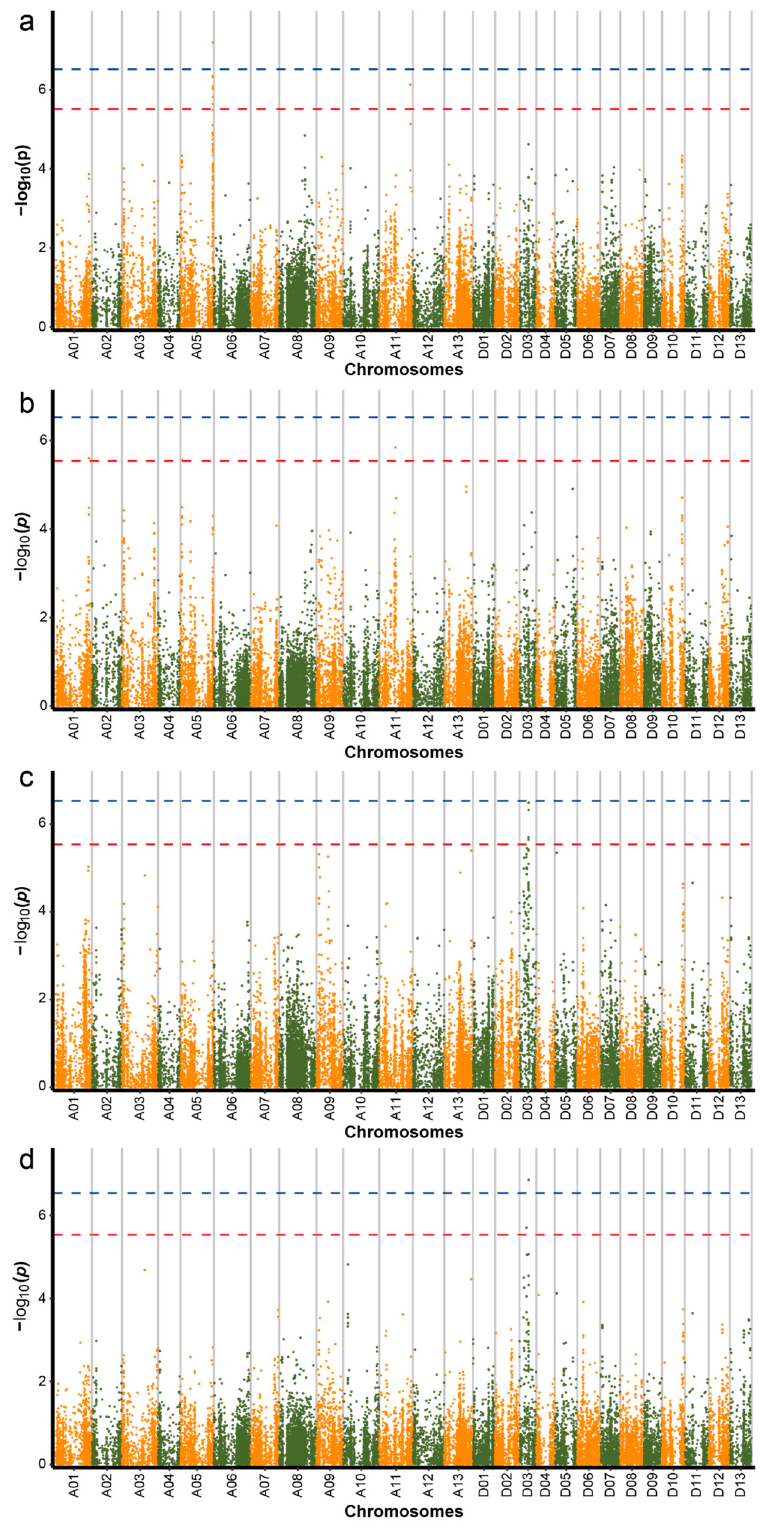
Figure 3. Genome-wide associated study (GWAS) of 316 upland cotton accessions. Manhattan plots of GWAS by using general linear model (GLM) for EWS ( a ), CWS ( b ), and LT ( c ), respectively and by using factored spectrally transformed linear mixed model (FASTLMM) for LT ( d ). The SNP loci of the red lines ( − log10( p ) ≥ 5.53) were considered suggestive association makers; the SNP loci of the blue lines ( − log10( p ) ≥ 6.53) were considered significant association makers. Each dot represents an SNP.